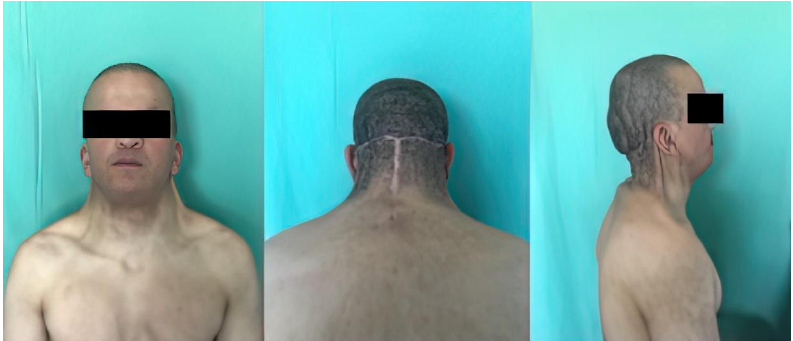
Figure 5. Results at 1 year postoperatively with a low hairline and lateral flanges.